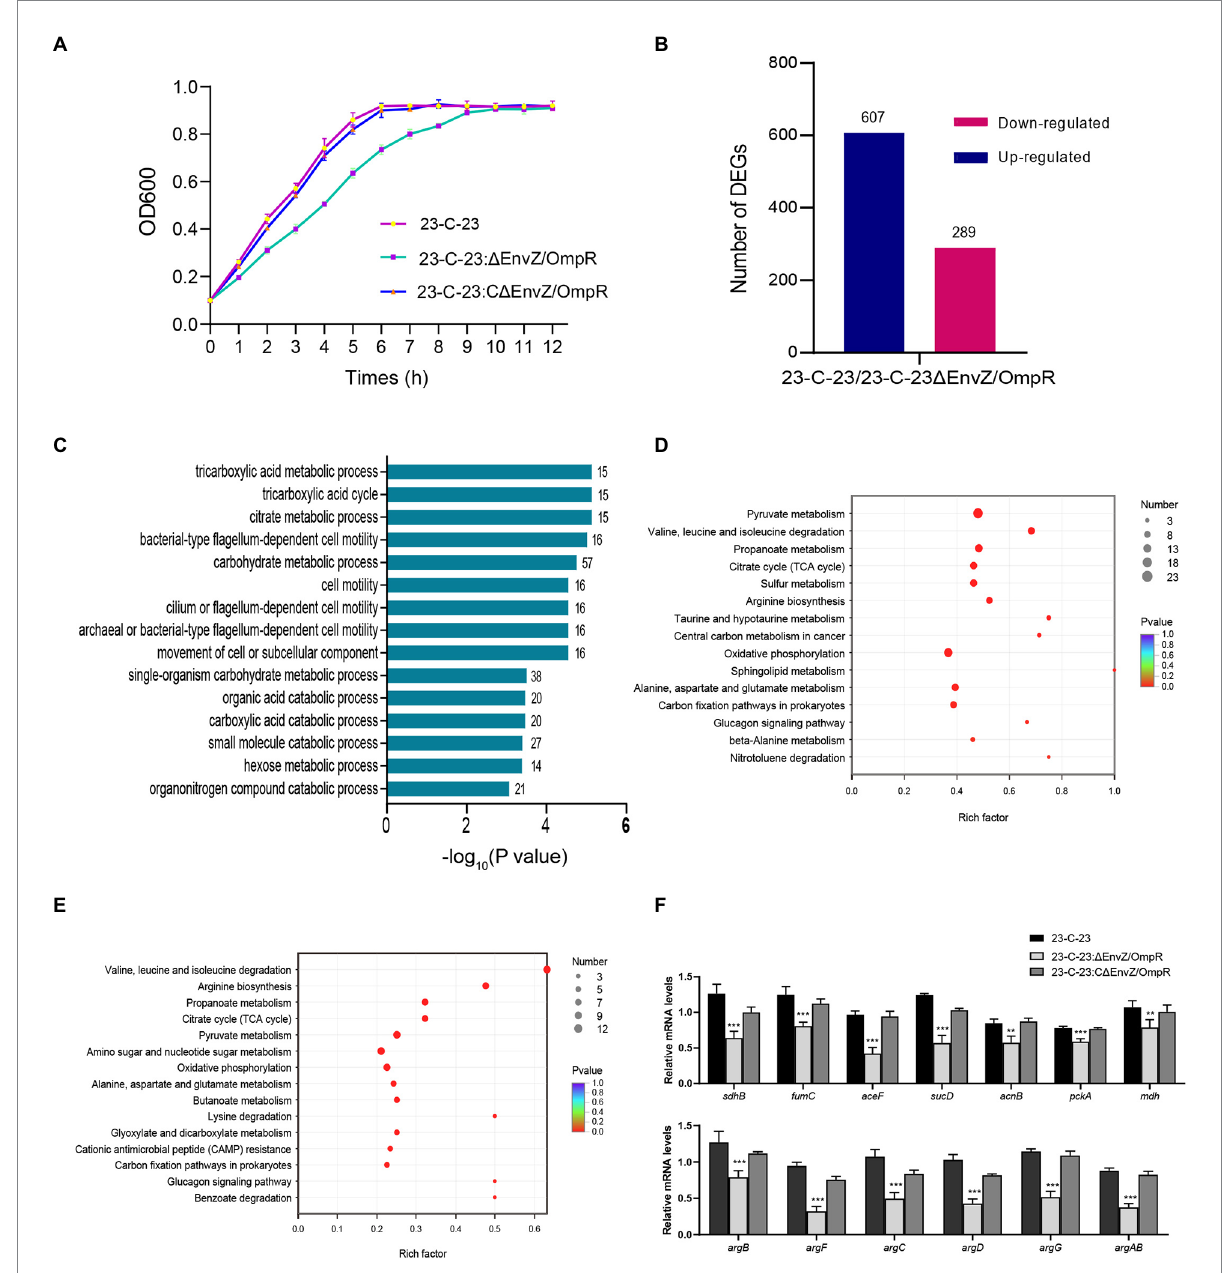
FIGURE 1 Effect of EnvZ/OmpR on growth of 23-C-23 . (A) Growth curve of 23-C-23 , 23-C-23: Δ EnvZ/OmpR, and 23-C-23:C Δ EnvZ/OmpR . (B) Numbers of increased and decreased differentially expressed genes (DEGs). Genes with a log 2 fold change > 1 or < − 1, and a p -value < 0.05 were defined significantly DEGs. (C) GO biology processes. The y-axis represents GO terms, and the x-axis represents the cluster frequency of the DEGs. The number represents the number of genes enriched. (D) KEGG pathway enrichment analysis of all DEGs. (E) KEGG pathway enrichment analysis of significantly downregulated genes. The size of the dots indicates the number of expressed genes in the pathways, and the color of the dots represents the negative logarithm of value of p of the pathway. (F) The expression levels of metabolic-related genes (up: TCA cycle; down: arginine biosynthesis). Values are expressed as the mean ± SD of three individual experiments. ** p < 0.01, and *** p < 0.001 compared with control